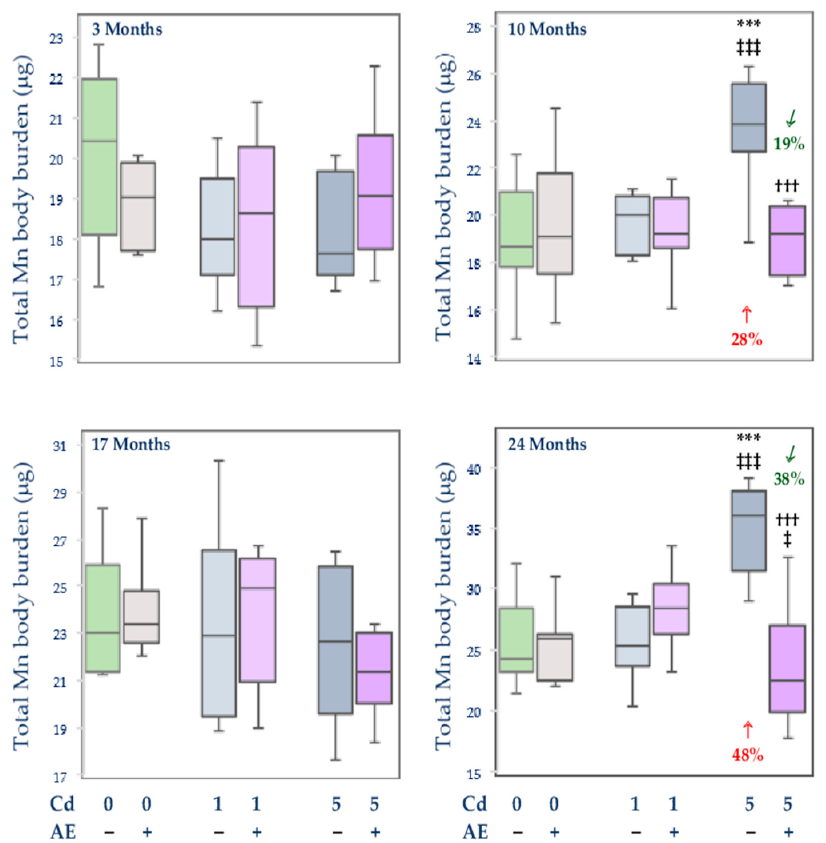
Figure 7. The total body burden of Mn in particular experimental groups. The rats received Cd in the diet at the concentration of 0, 1, and 5 mg/kg and/or 0.1% AE as the only drinking fluid (“+”, administered; “ − ”, without administration). Data represent a median and 25–75% confidence interval (the horizontal lines within the bars presenting the confidence interval represent median values), as well as the minimum and maximum values for eight rats in each experimental group (except for seven animals in the AE, Cd1, and Cd5 groups after 24 months). Statistically significant differences: *** p < 0.001 vs. control group; ††† p < 0.001 vs. the Cd5 group; ‡ p < 0.05, ‡‡‡ p < 0.001 vs. respective group receiving the 1 mg Cd/kg diet alone (Cd1 group) or with the AE (Cd1 + AE group) are marked. The values below and above the bars indicate percentage changes compared to the control group ( ↑ , increase) or the respective group receiving Cd alone ( ↓ , decrease), respectively.